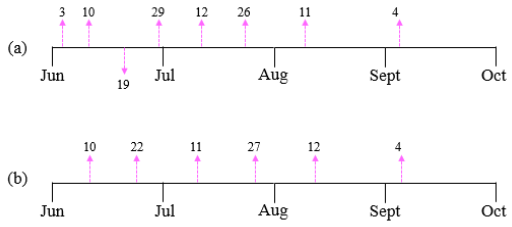
Figure 5. The sampling dates in 2020 ( a ) and 2021 ( b ) seasons.